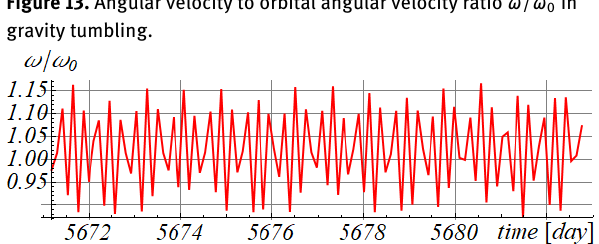
Figure 14. Quasi-periodic variations of ω / ω 0 in gravitational tum- bling (a close up view of the plot in Figure 13)